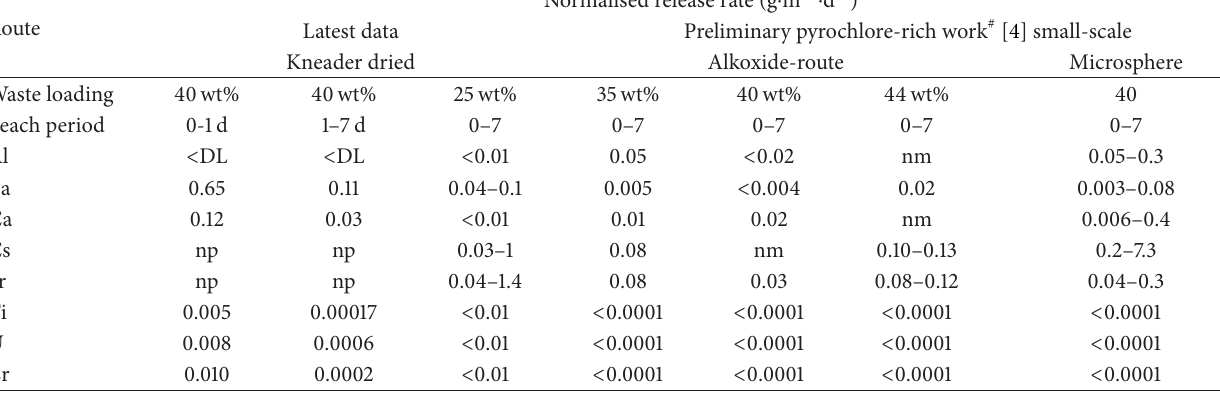
Table 4: Leach rates for the HIPed sample shown in Figure 4. MCC-1 replacement test 0-1 and 1–7 day periods, 90 ∘ C, deionised water. Data from earlier work (0–7 days) [4] are also given; note that after the 7d leach period the leach rates drop to less than or close to the detection limit for all elements.